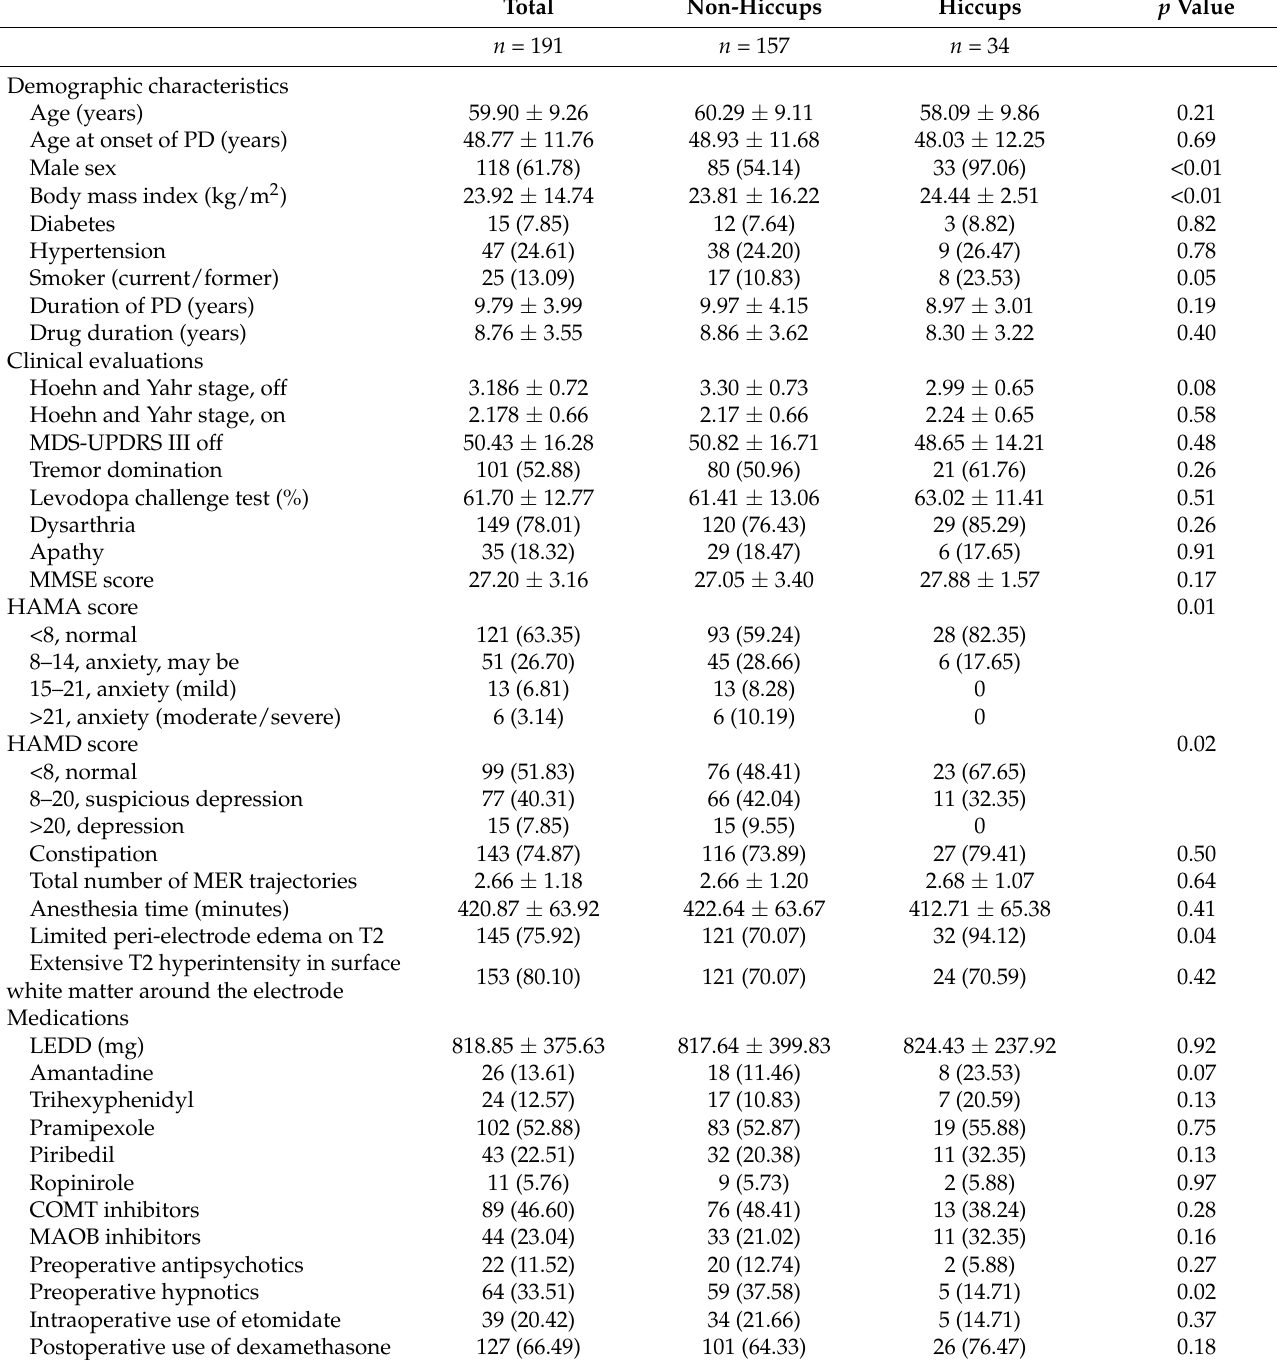
Table 1. Baseline characteristics and univariate analysis of postoperative hiccups in PD patients after STN-DBS under general